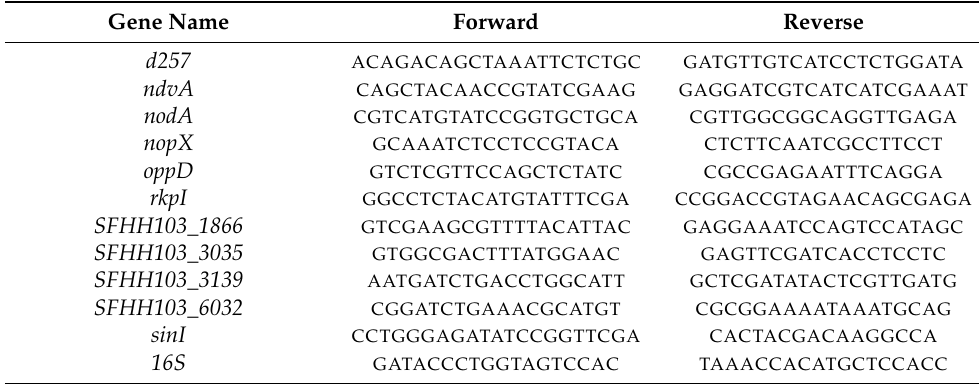
Table 1. Selected genes and primer sequences for q RT-PCR